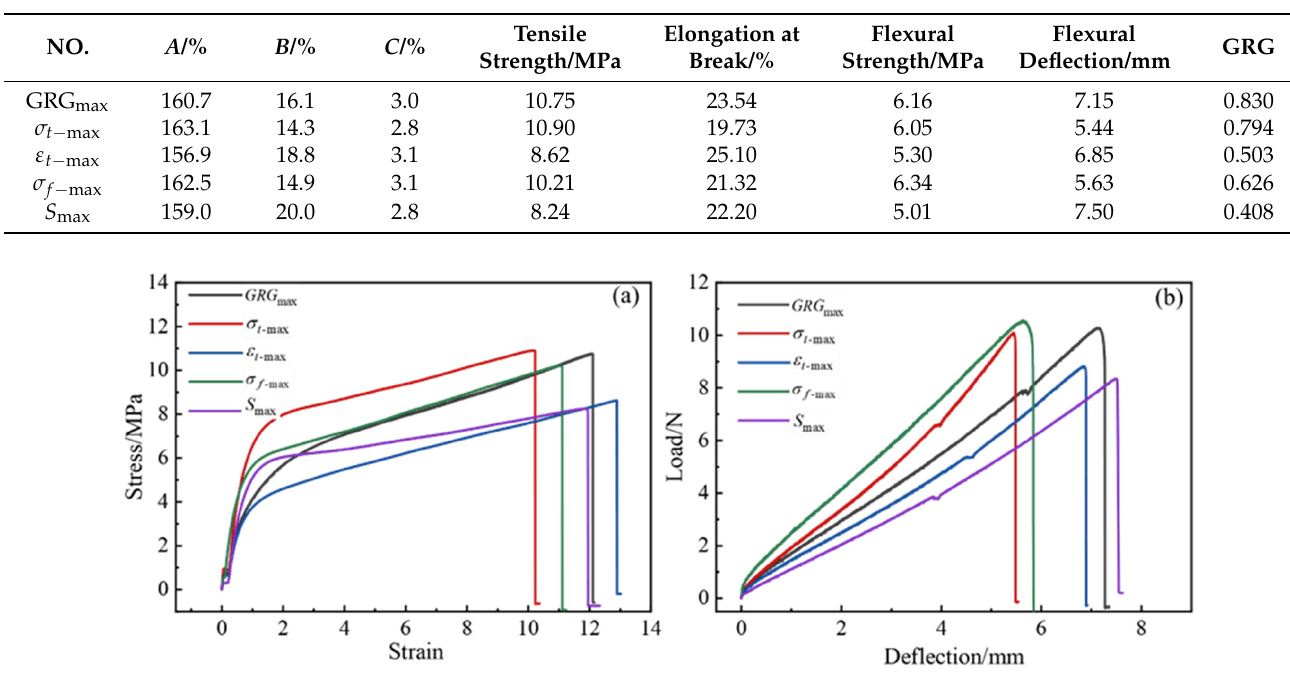
Table 8. Response optimal ratio experimental comparison table.